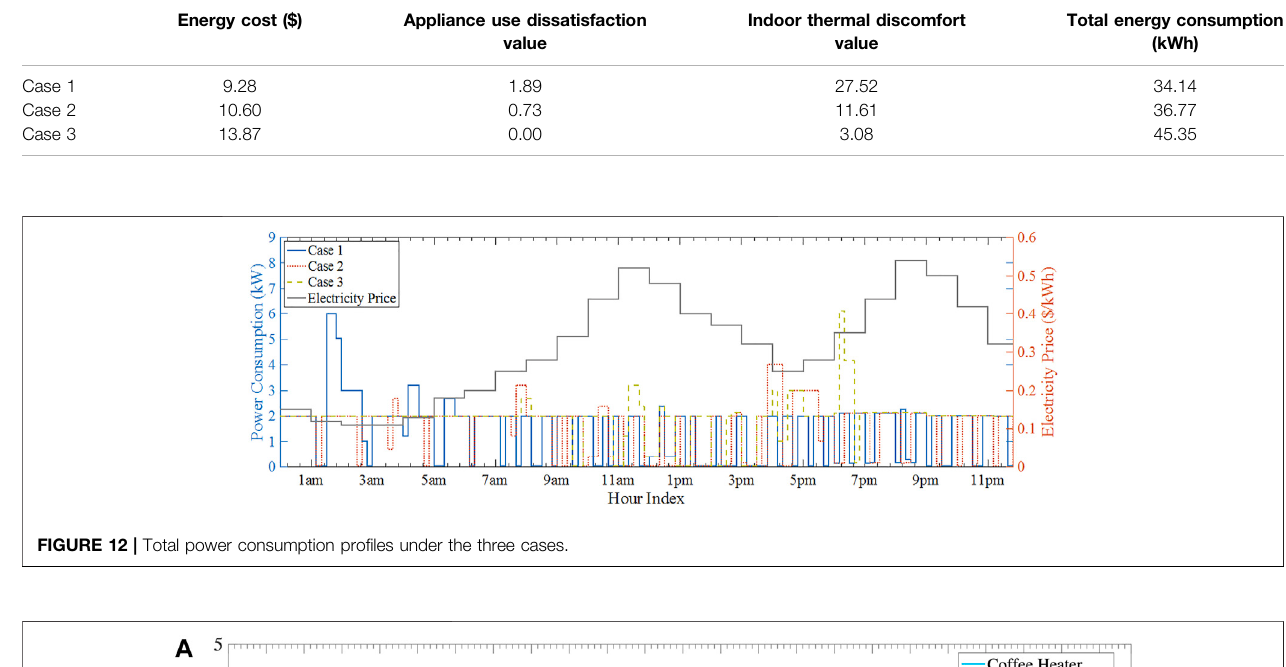
Frontiers in Energy Research |